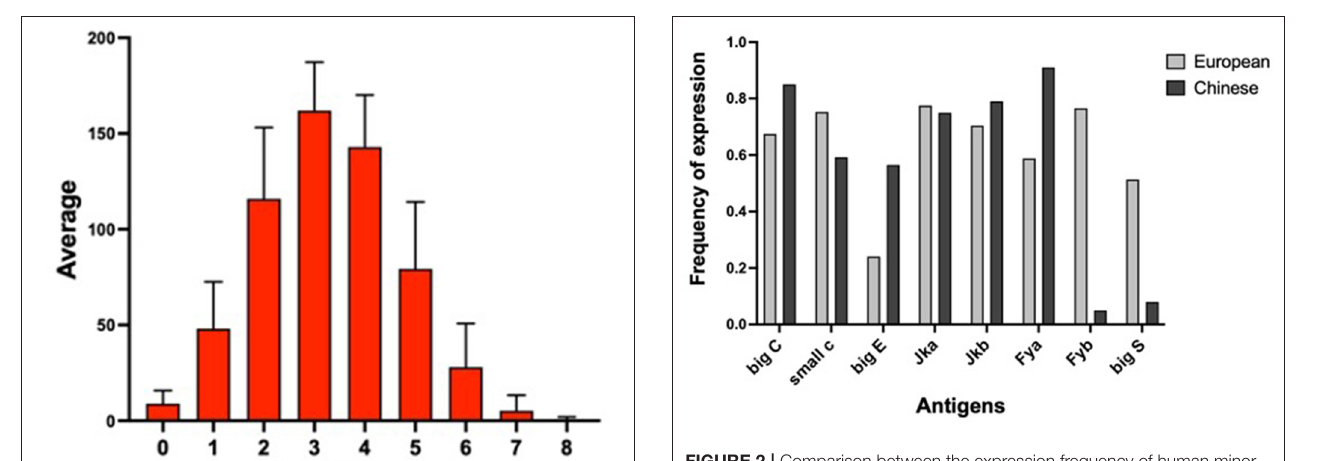
possible “false-negative”